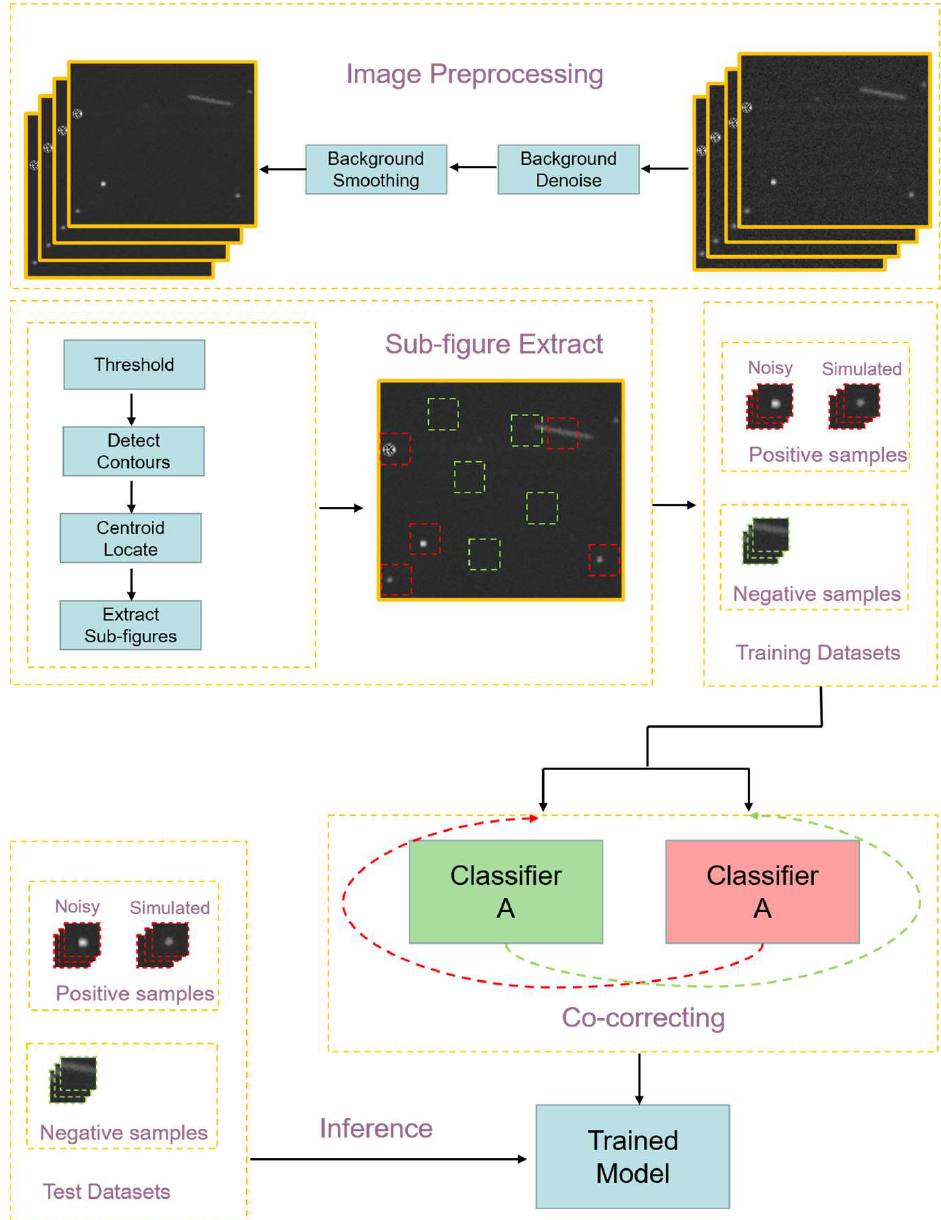
Figure 1. The pipeline of Co-correcting in space debris detection. The original observation images are processed by background denoise and background smoothing to acquire a clean